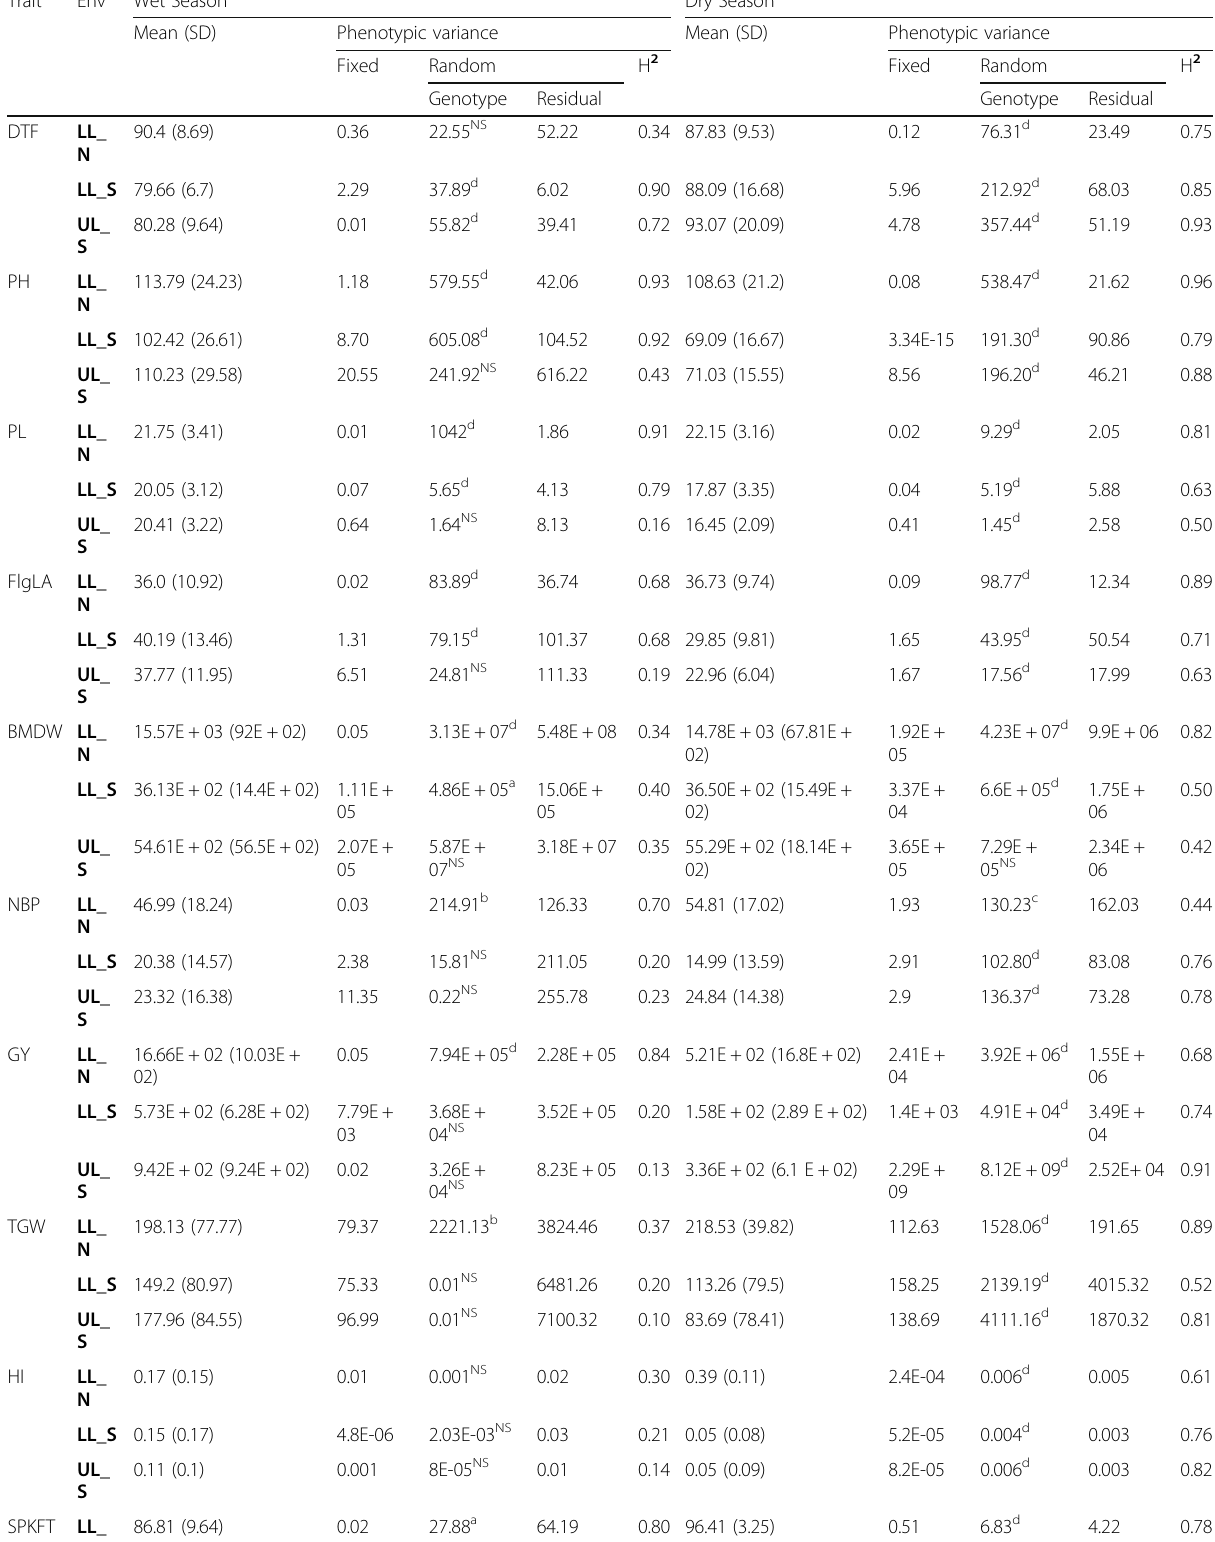
Table 1 Summary statistics and sources of variation for the ten phenotypic traits under three different environments and two seasons for the diverse set of 280